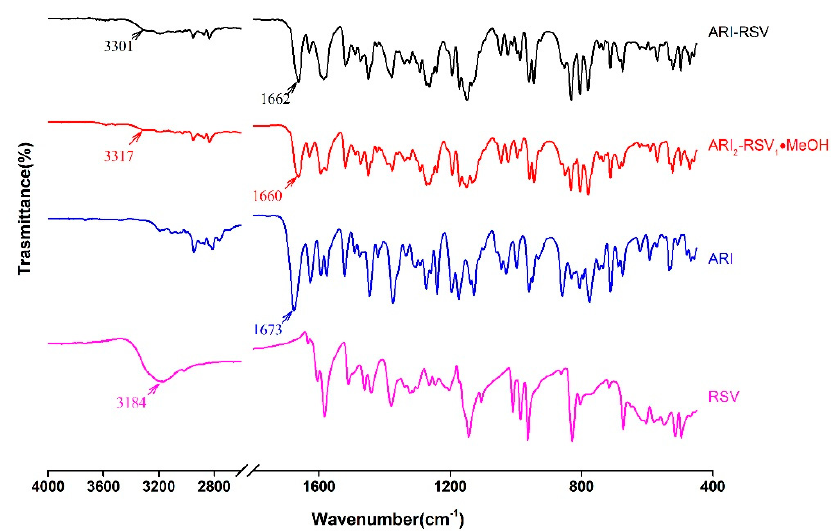
Figure 9. The ATR-FTIR spectrum of ARI, RSV, and their cocrystals.